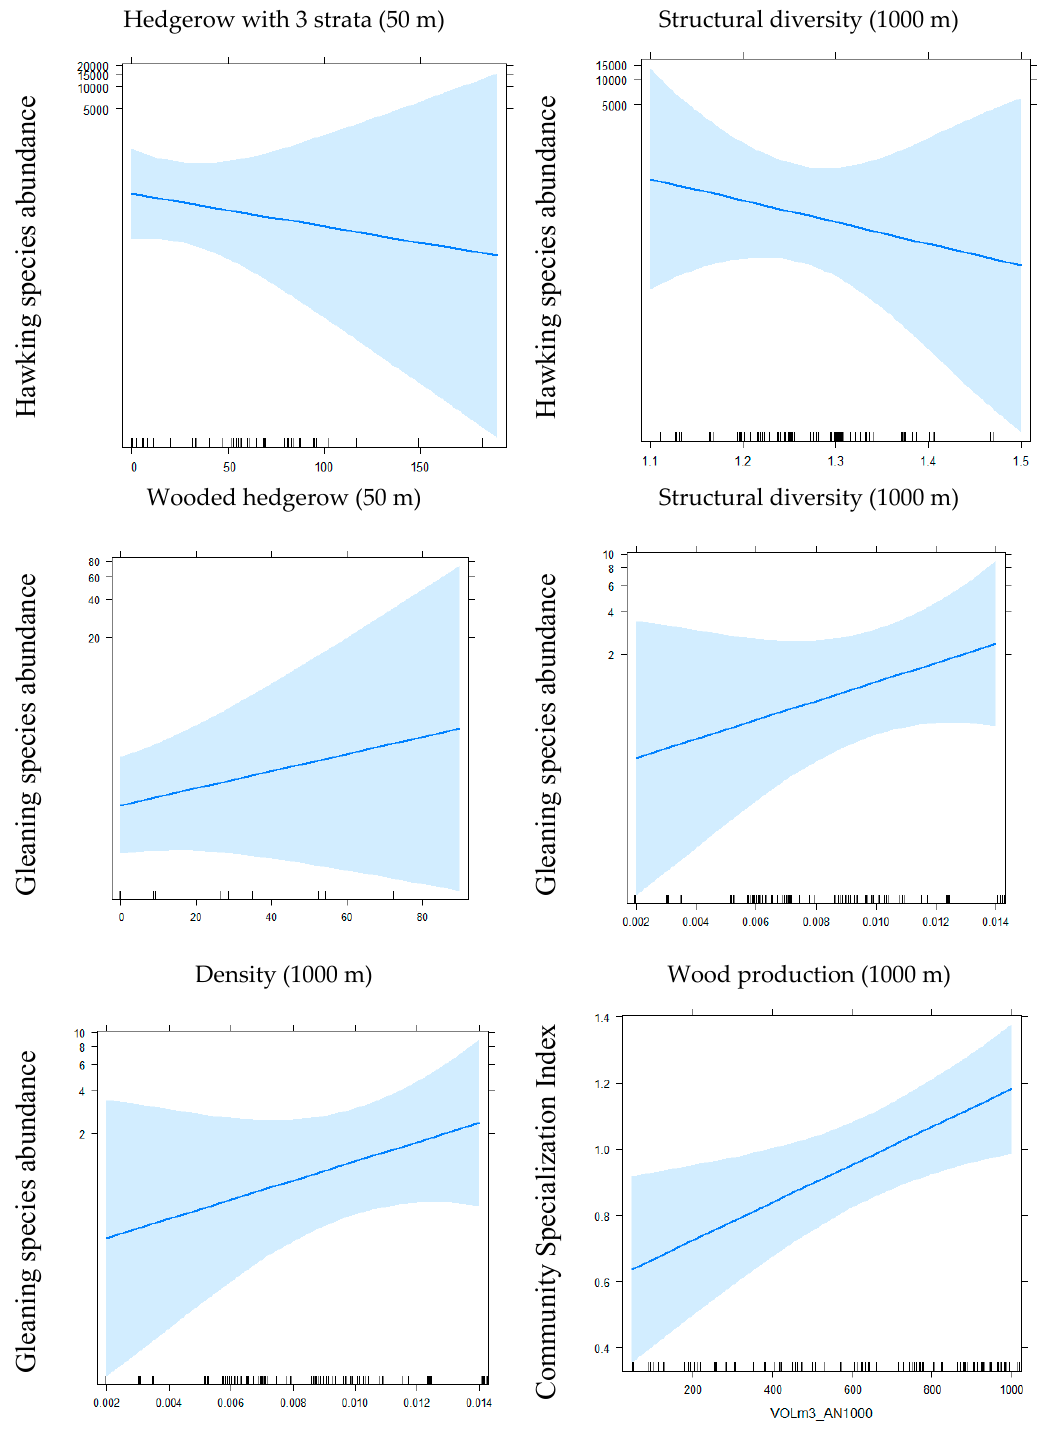
Figure 1. Main effects of local and landscape variables of hedgerows on bat communities’ indices. More generally, for the group of hawking species, two local variables, alignment of trees and shrub hedgerow, had a significant positive effect while the “three-strata hedgerow” variable had a negative effect and, on the landscape scale, structural diversity had a negative effect. For the group of gleaning species, on the local scale, the variable “alignment of trees” had a positive effect, while the number of wooded hedgerows and shrub hedgerows had a negative effect and, on the landscape